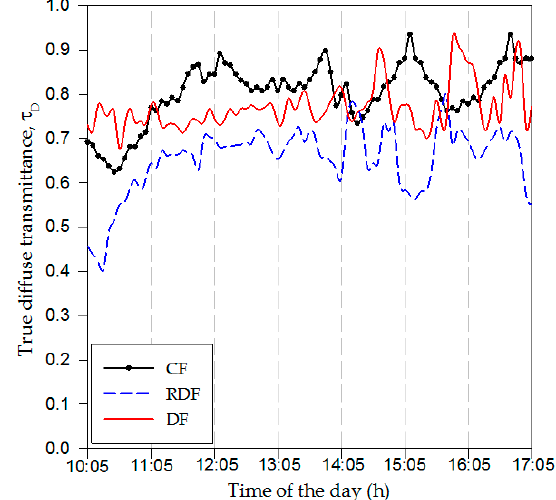
Figure 6. Time course of the true transmittances of the three films to di ff use radiation ( τ D ); the films and the pyranometers were exposed to diffuse radiation, (14 – 16 October 2019).